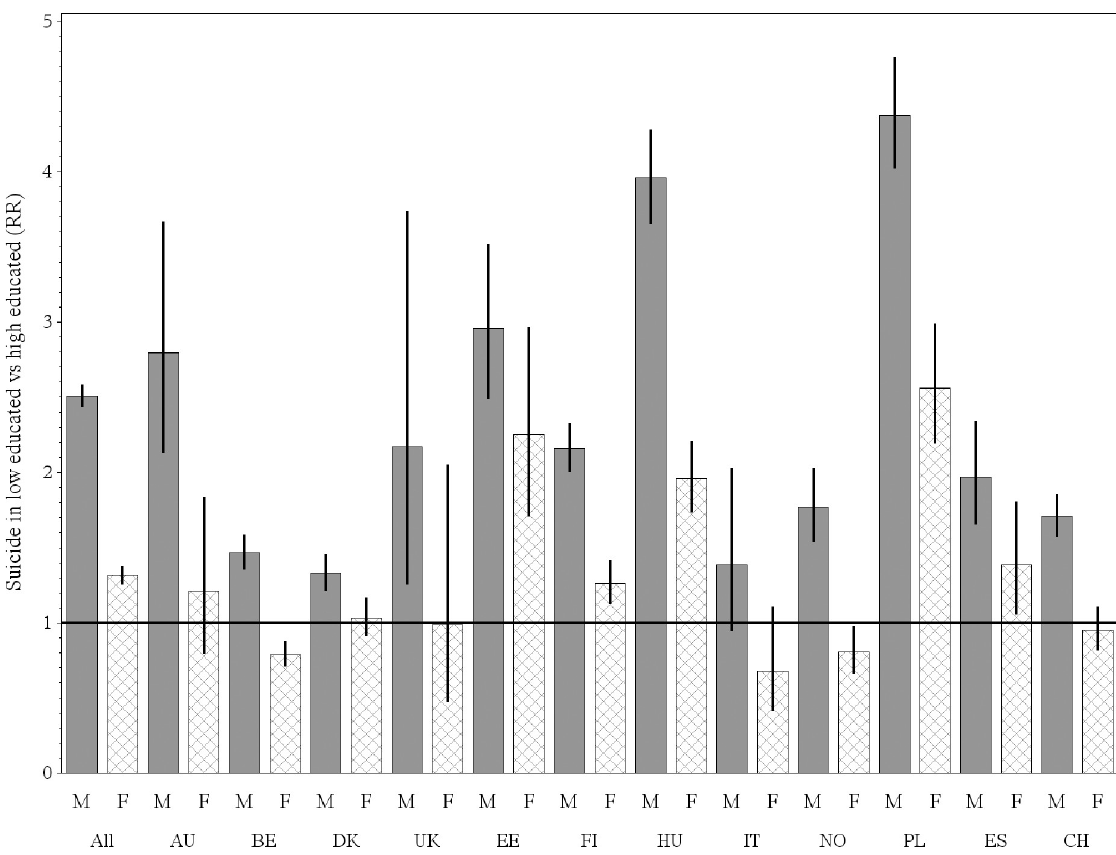
Fig 3. Educational disparities in suicide per population and gender (F = Women, M = Men): Pooled and weighted results and population-specific risk ratio of suicide from the Poisson regressions, DEMETRIQ study from twelve European populations, 1991–